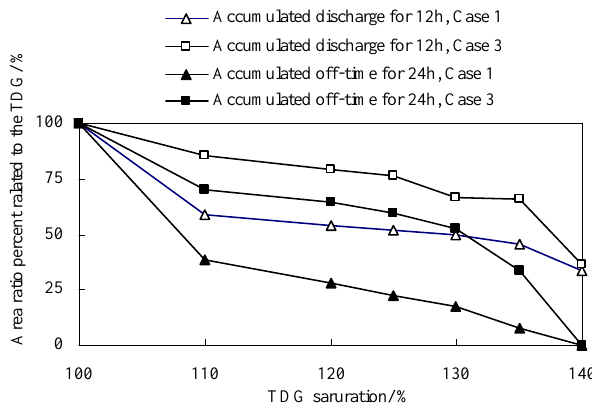
Fig. 14. Comparison of TDG distribution of Case 1 (a) and Case 3 (b) at the moment of accumulative discharge time of 12h.